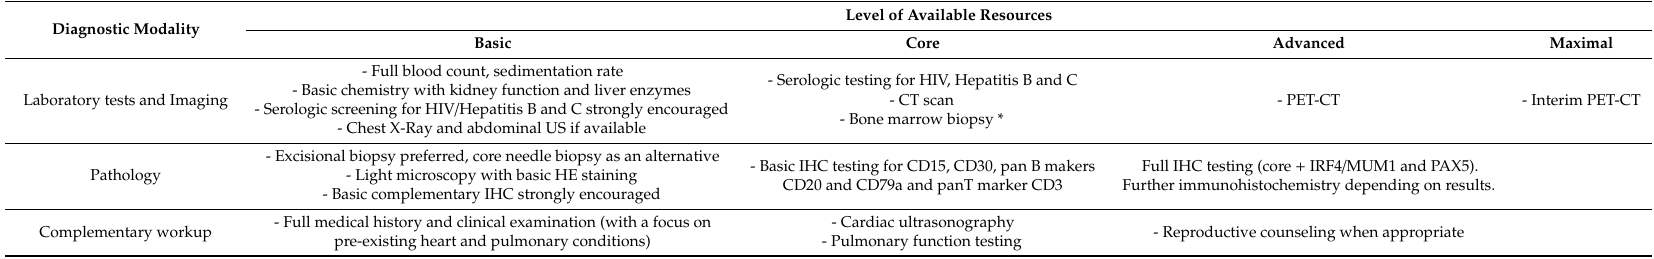
Table 1. Diagnosis and staging recommendations according to level of available resources.